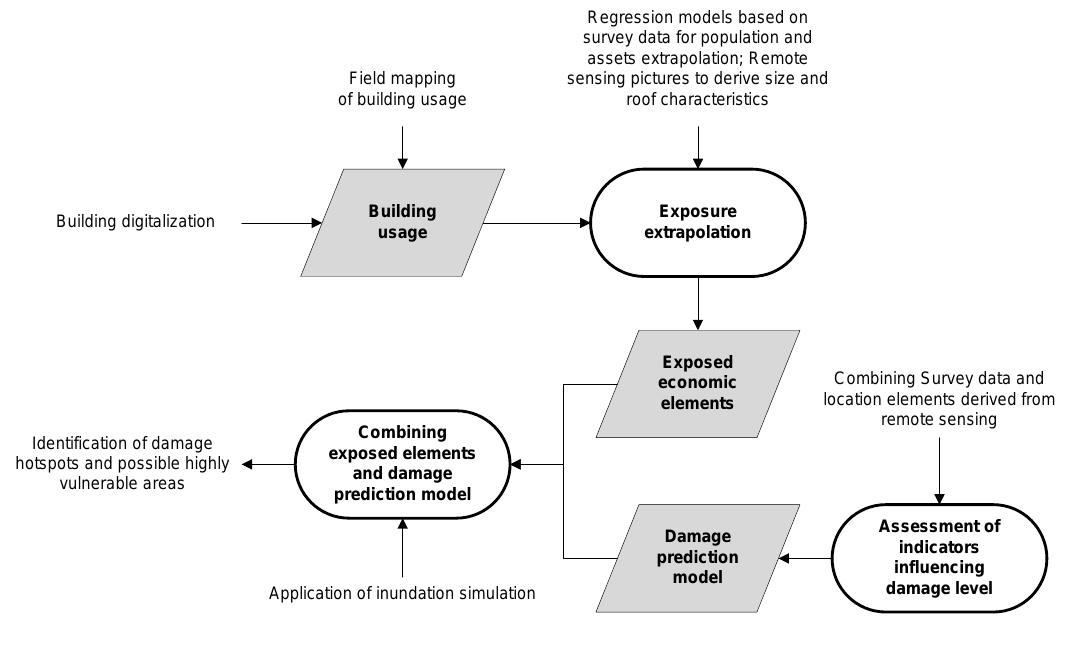
Fig. 4. Methods used to identify vulnerable areas